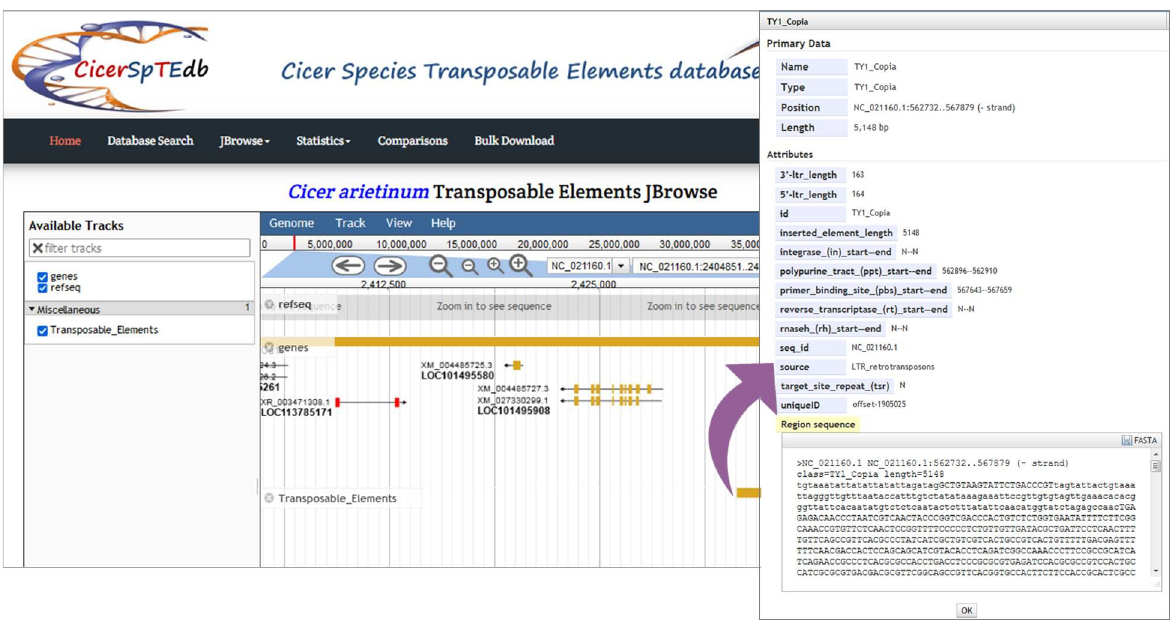
Fig 9. CicerSpTEdb’s JBrowse